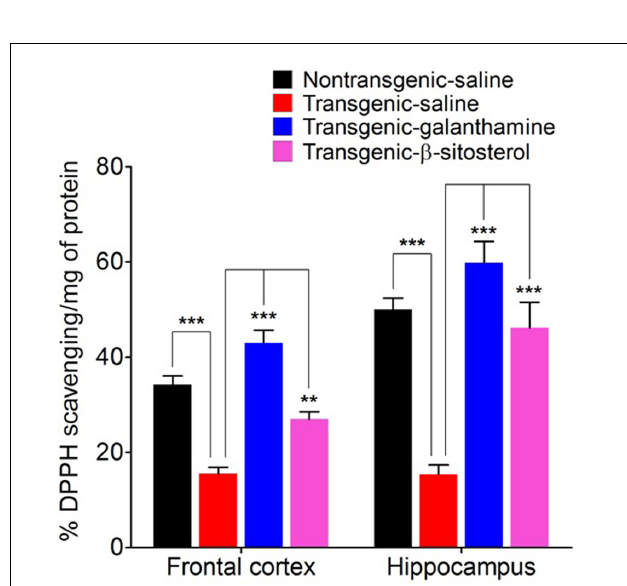
FIGURE 7 | DPPH free radical scavenging activity of proteins expressed in the frontal cortex and hippocampus after treatment with galanthamine and β -sitosterol. Bars represent mean percent DPPH activity ± SEM. ∗∗ P < 0.01, ∗∗∗ P < 0.001, one-way ANOVA followed by post hoc Tukey’s multiple comparison